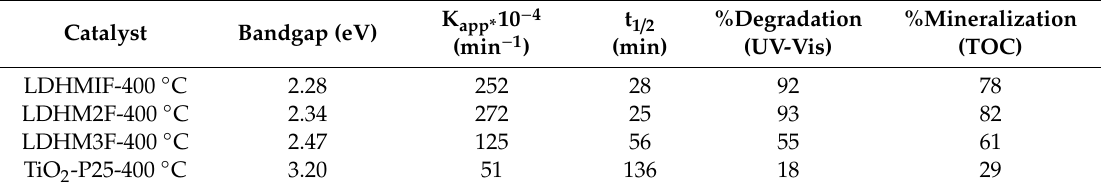
Table 2. Bandgap energy, specific area, apparent kinetic constant, half-life, percentage of degradation, and percentage of mineralization of activated layered double hydroxides.